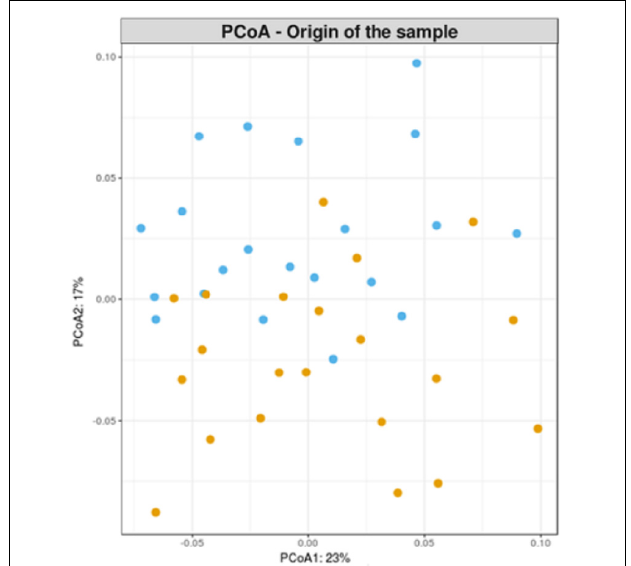
FIGURE 2 | Principal coordinate analysis on weighted Unifrac phylogenetic distance matrix. Cecal and fecal samples are blue and orange colored,